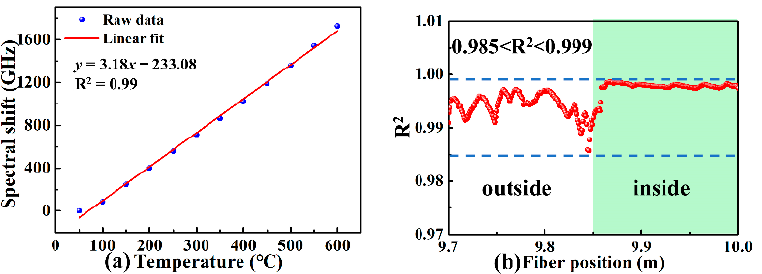
Figure 6. ( a ) Measured spectral shift as a function of the applied temperature at 9.95 m of the FUT and ( b ) 9.7–10 m when the furnace temperature increased from 50 to 600 °C. Furthermore, the spectral shift variation, i.e., cumulative error along the FUT, of DM-1D, DM-2D, SM-1D and SM-2D, was also investigated when no temperature was applied. As shown in Figure 7, the corresponding mean and standard deviations calculated by DM-1D, DM-2D, SM-1D and SM-2D were 2.49 ± 0.70, 2.50 ± 0.36, 4.77 ± 1.51 and 4.51 ± 0.91 GHz, as represented by the pink, red, orange and green curves, respectively. This indicated that the SM could effectively expand the temperature demodulation range, i.e., a larger measurement range, but the cumulative error was larger than that of DM. The spectral shift caused by the cumulative error for SM-2D was 4.51 GHz, and the accuracy of the demodulated temperature was 0.91 GHz, corresponding to temperatures of 1.18 and 0.24 ◦